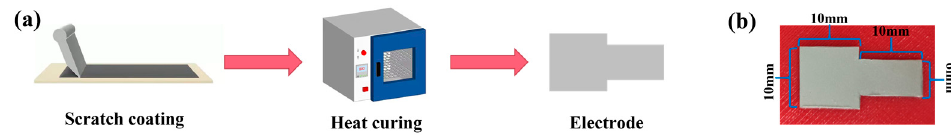
Figure 3. Fabrication of the electrode layer. ( a ) The fabrication process; ( b ) the actual image.